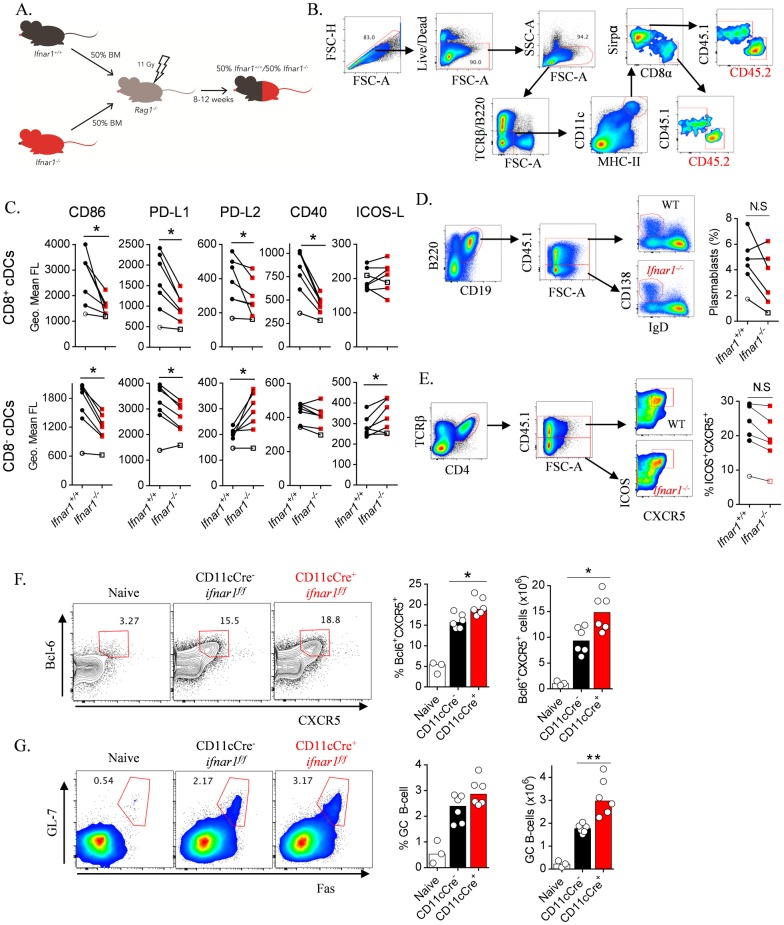
IFNAR1-signalling via cDCs limits Tfh and GC B-cell responses.(A) Schematic for the mixed bone marrow chimeric approach: 50:50 mixed WT (Ifnar1
+/+; CD45.1) and Ifnar1
-/- (CD45.2) bone marrow was transferred into lethally-irradiated rag1
-/- mice (to avoid potential issues with residual radio-resistant T- and B-cells), and subsequently left for 8–12 weeks prior to infection studies. (B) Gating strategy for splenic WT (CD45.1+) and Ifnar1
-/- (CD45.2+) CD8+ (TCRβ- B220- CD11chi MHC-IIhi CD8α+) and CD8- (TCRβ- B220- CD11chi MHC-IIhi Sirpα+ CD8-) conventional DCs. (C) Paired analysis between splenic WT and Ifnar1
-/- cDC subsets in individual mice for cell-surface expression of CD86, PD-L1, PD-L2, CD40 and ICOS-L, 2 days p.i. with Py17XNL. Data representative of two independent experiments. Statistics: Wilcoxon test, *P<0.05. (D) Representative FACS plots and proportions for WT (CD45.1+) Ifnar1
+/+ and Ifnar1
-/- plasmablasts, 7 days p.i. with PcAS infection. Data representative of 2 independent experiments. Statistics: Wilcoxon test. (E) Representative FACS plots and proportions for WT (CD45.1+) Ifnar1
+/+ and Ifnar1
-/- CD4+ T cells expressing ICOS and CXCR5, 7 days p.i. with PcAS infection. Experiment performed once. Statistics: Wilcoxon test, *P<0.05. (F) Representative FACS plots (gated on CD4+ TCRβ+ live singlets), proportions and absolute numbers of splenic Tfh cells and (G) splenic GC B-cells (gated on B220+ CD19+ live singlets) in CD11cCre+/-
ifnar1
f/f and CD11cCre-/-
ifnar1
f/f littermates (n = 6) (WT naïve mice as staining controls), on day 6 p.i. with Py17XNL; Statistics: Mann-Whitney U-test **P<0.01, *P<0.05. Data representative of 2 independent experiments.